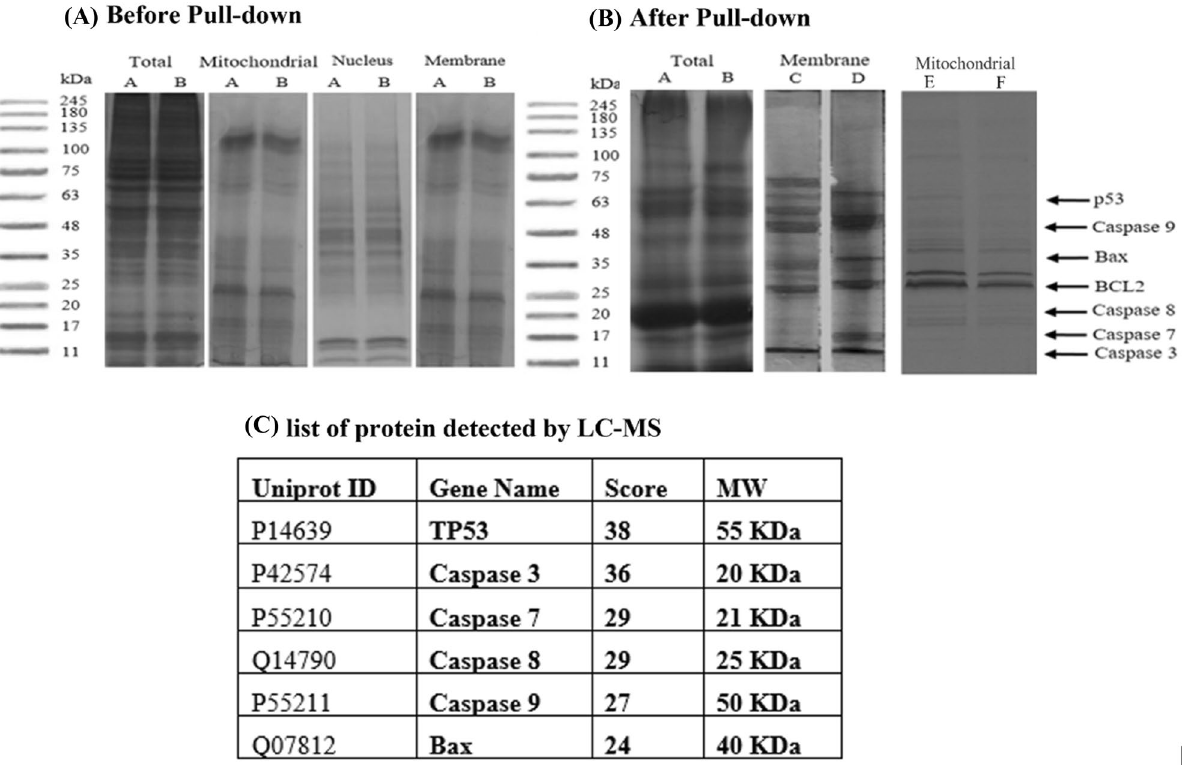
Figure 16. Peptide-protein immunoprecipitation analysis. ( A ) Total, membrane, and mitochondrial cell lysate before pulldown. (BA) total proteins linked to AtMP1 (BA) and (BB) total proteins linked to AtMP2 (BC) membrane proteins linked to AtMP1, and (BD) membrane proteins linked to AtMP2, and (BE) mitochondrial proteins linked to AtMP1, and (BF) mitochondrial proteins linked to AtMP1. ( C ) The list of cell proteins detected in LC–MS. (Gel blot figures are combination of different gels. The original pictures are shown in (Supplementary Figs. S18, S19, S20, S21, S22, S23,